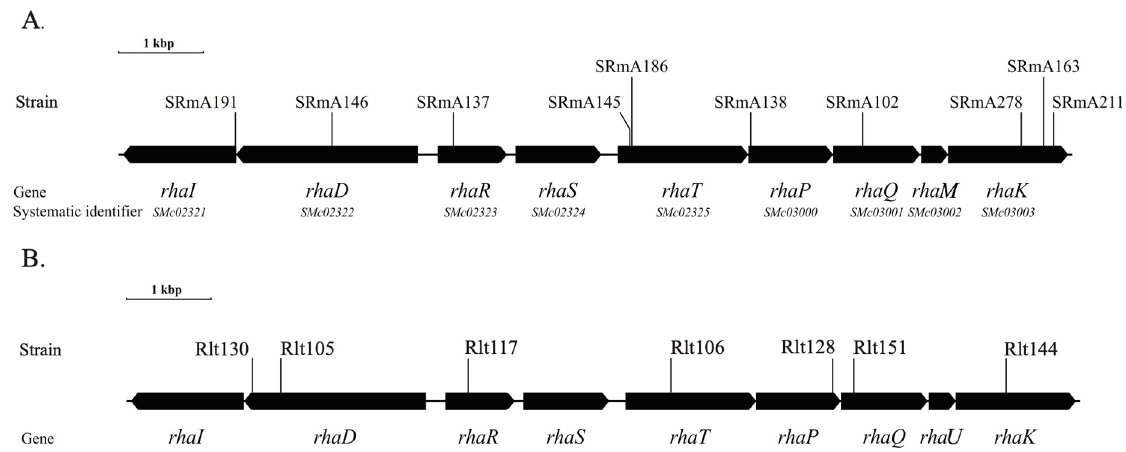
Figure 1. The rhamnose catabolic regions in S. meliloti strain Rm1021 ( A ), and R. leguminosarum bv. trifolii strain Rlt100 ( B ). Solid arrows represent the genes and the direction of transcription at each locus. Vertical lines represent sites of Tn 5 or Tn 5 -B20 insertion. Strain names corresponding to specific alleles are given above the genes, while gene names are given below the genes. In the case of S. meliloti , the systematic identifier numbers are also shown.